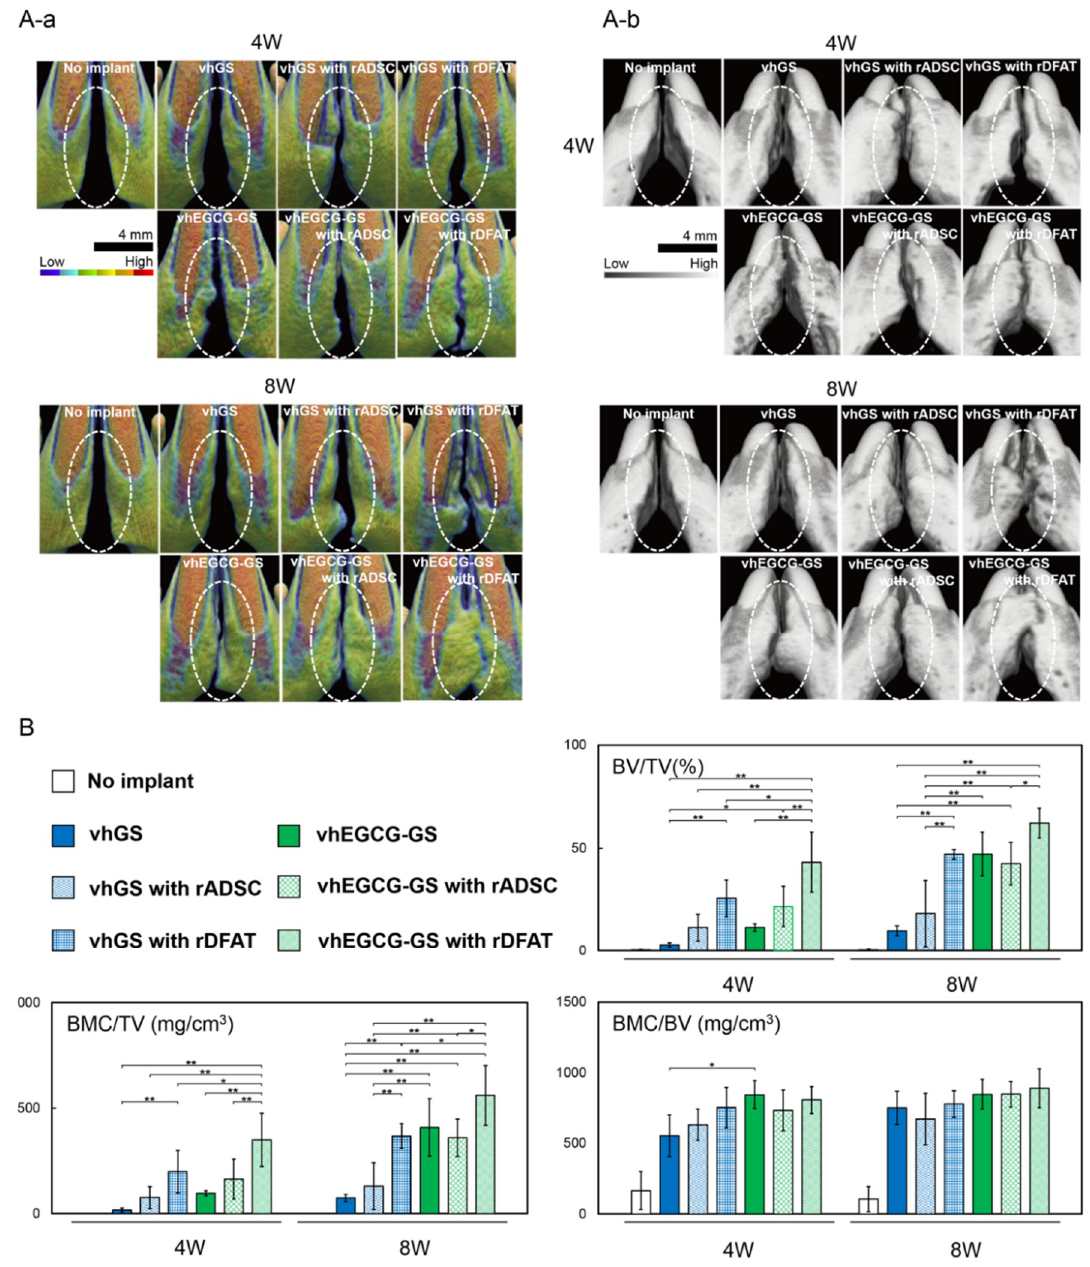
Figure 5. Micro-computed tomography ( µ CT) analysis of new bone formation in the congenital cleft-jaw model. ( A-a ) Representative bone mineral density image of the defects at 4 and 8 weeks after the surgery; anterior view. ( A-b ) Representative µ CT images of the defects at 4 and 8 weeks after the surgery; diagonally upward view. ( B ) Bone morphometric analysis. BV: bone volume; TV: total volume; BMC: bone mineral content. * p < 0.05, ** p < 0.01 (one-way ANOVA with a Tukey–Kramer test; All statistical significance except for the comparison against no implant was highlighted). The bar graph shows the mean with standard deviation ( n = 5).